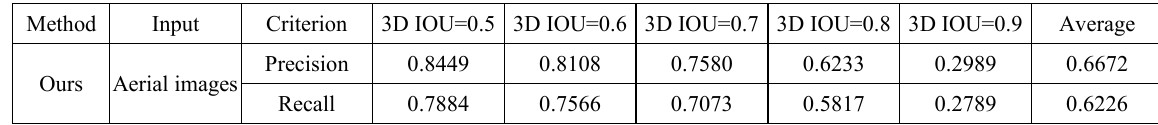
Table 3. The performance of our proposed 3D building reconstruction